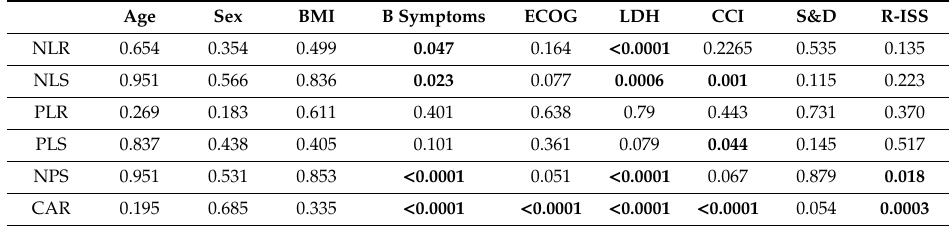
Pearson’s correlation between composite ratios and cumulative scores and baseline clinicopathological characteristics of patients with multiple myeloma undergoing autologous hematopoietic stem cell transplantation (HSCT) ( n =